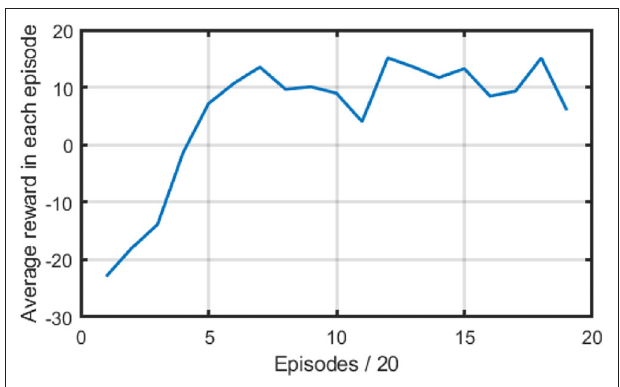
FIGURE 4 | The average reward in each episode in the reinforced training